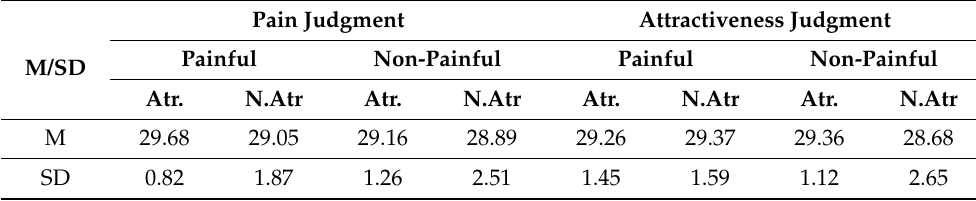
Table 1. Breakdown of the average number of valid trials per condition. Pain Judgment Attractiveness M/SD